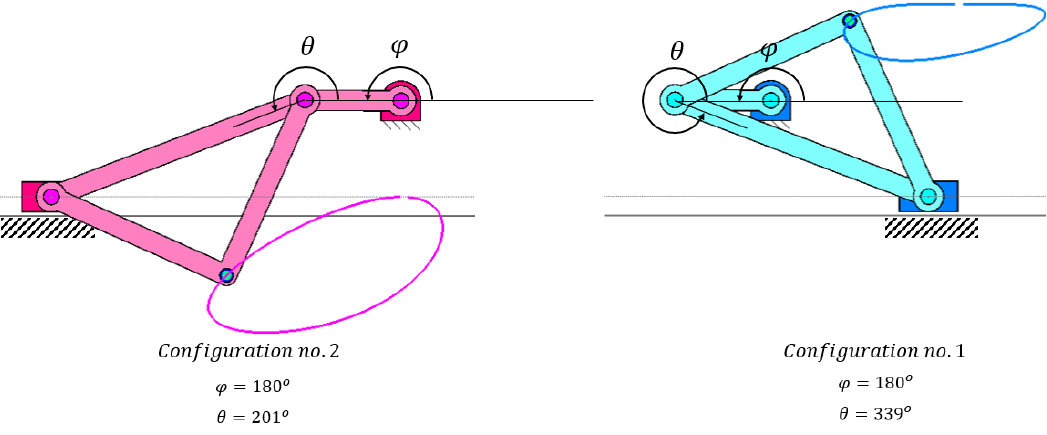
Figure 2. Two possible configurations for the same input.